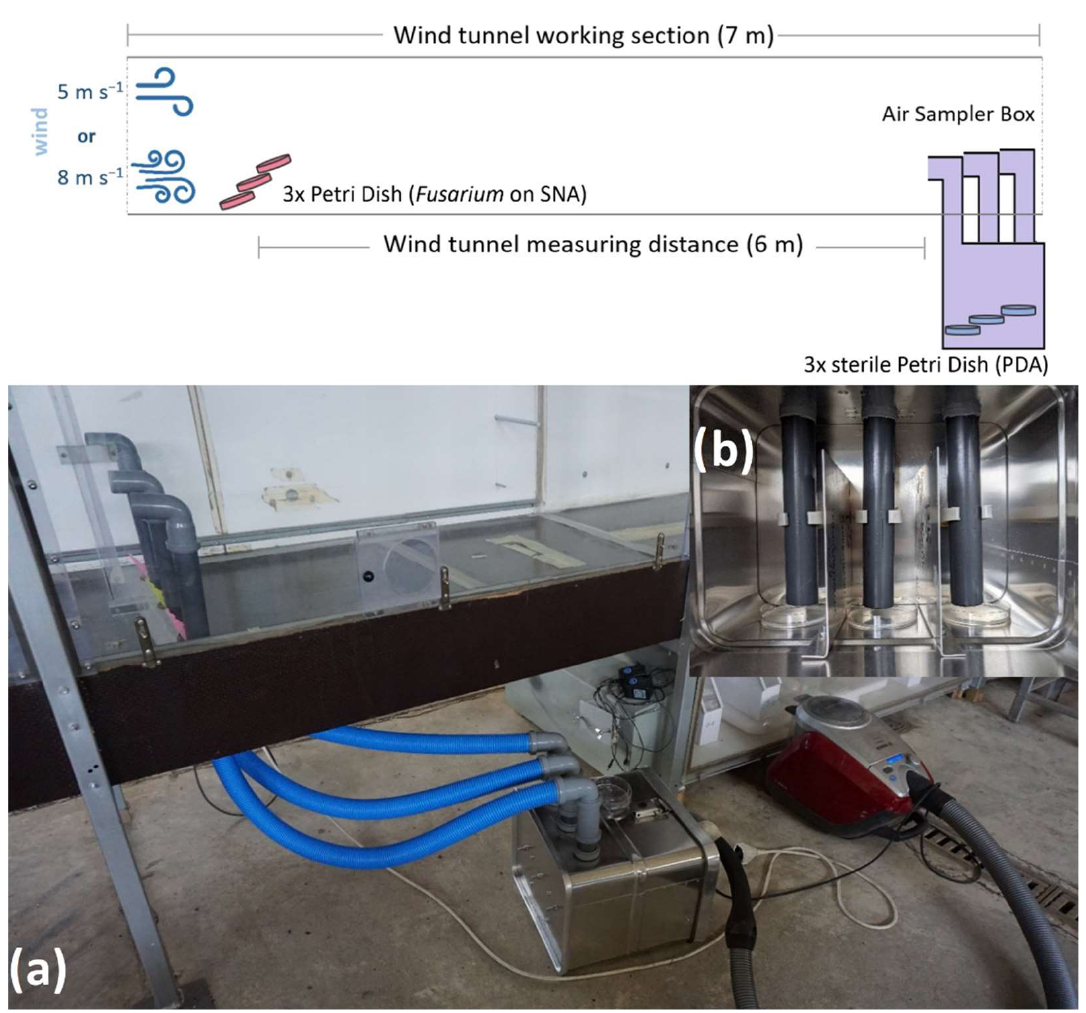
Figure 1. Schematic of the wind tunnel setup. At the beginning of the working section, the three Petri Dishes containing the Fusarium species on Synthetic Nutrient-Poor Agar (SNA) to be examined are placed at an angle of 45 ◦ . The Air Sampler Box (ASB) is used to capture the spores that are in the air. The ASB is installed at the end of the wind tunnel working section (in 6 m distance to samples). Three tubes direct the air into the box (here elevated tubes for control measurements; during Fusarium wind tunnel treatment (wtt), tubes are at the same height as Petri Dishes); at the end, an adjustable vacuum cleaner is connected ( a ). Inside the box, the tubes end over sterile Petri Dishes with Potato Dextrose Agar media (PDA) to catch fungal spores ( b ). With this setup, a total of 10 Fusarium species were tested for wind dispersal at 5 and 8 m s − 1 in three to four replicates.